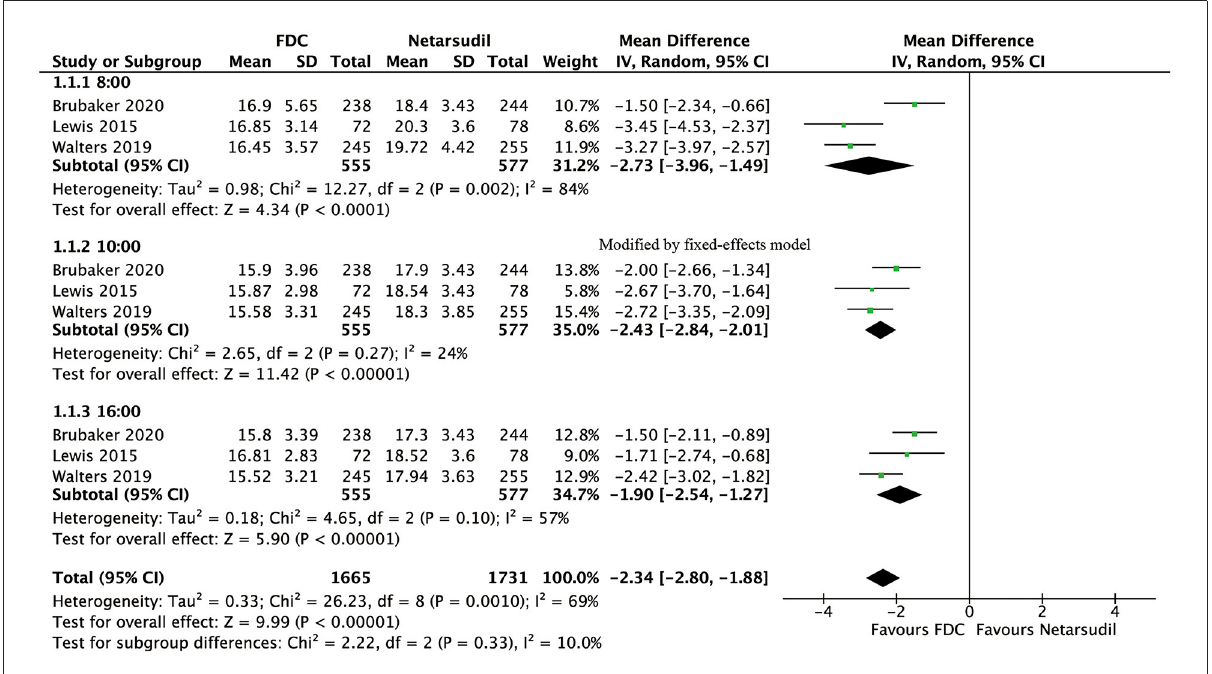
FIGURE2 Forest plot of WMD of IOP at 3 time points (8:00a.m., 10:00a.m., 4:00 p.m.) associated with FDC vs. netarsudil.